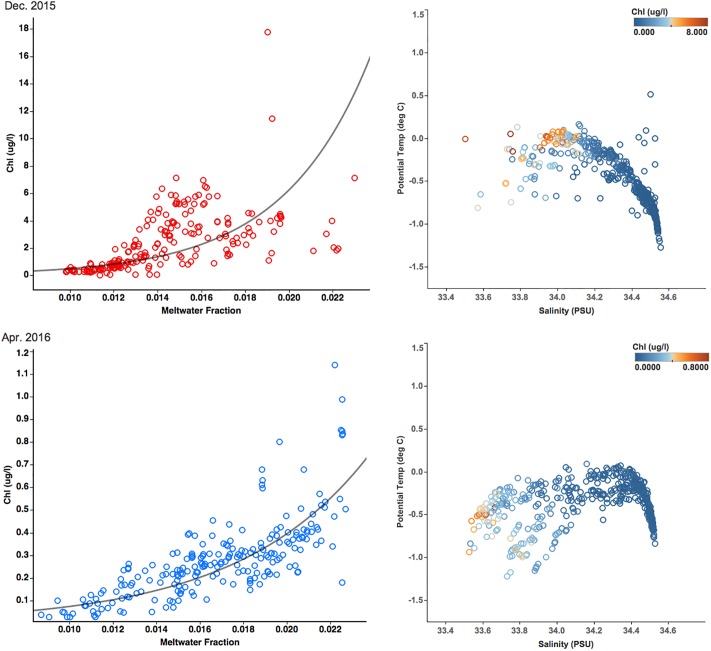
The relationship between meltwater fraction and chlorophyll-a concentration.Left panels: In the surface layer between 0 m and 40 m depth in Andvord Bay, the exponential regression between the two variables has a correlation coefficient of 0.66 and p-value of <0.0001 in December 2015, while the correlation coefficient is 0.82 and p-value is <0.0001 in April 2016. Right panels: T-S diagrams of Andvord Bay during December and April with color indicating chl-a concentration.